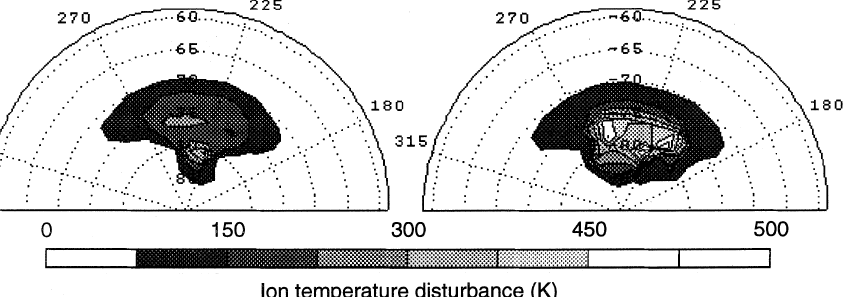
Fig. 5. Geomagnetic polar plots (latitudes 60 (cid:176) –90 (cid:176) ) of the calculated ionospheric disturbances, i.e., the di(cid:128)erences between disturbed and undisturbed values of the calculated ionospheric parameters, at h (cid:136) 300 km in the Northern (summer, left plot ) and Southern